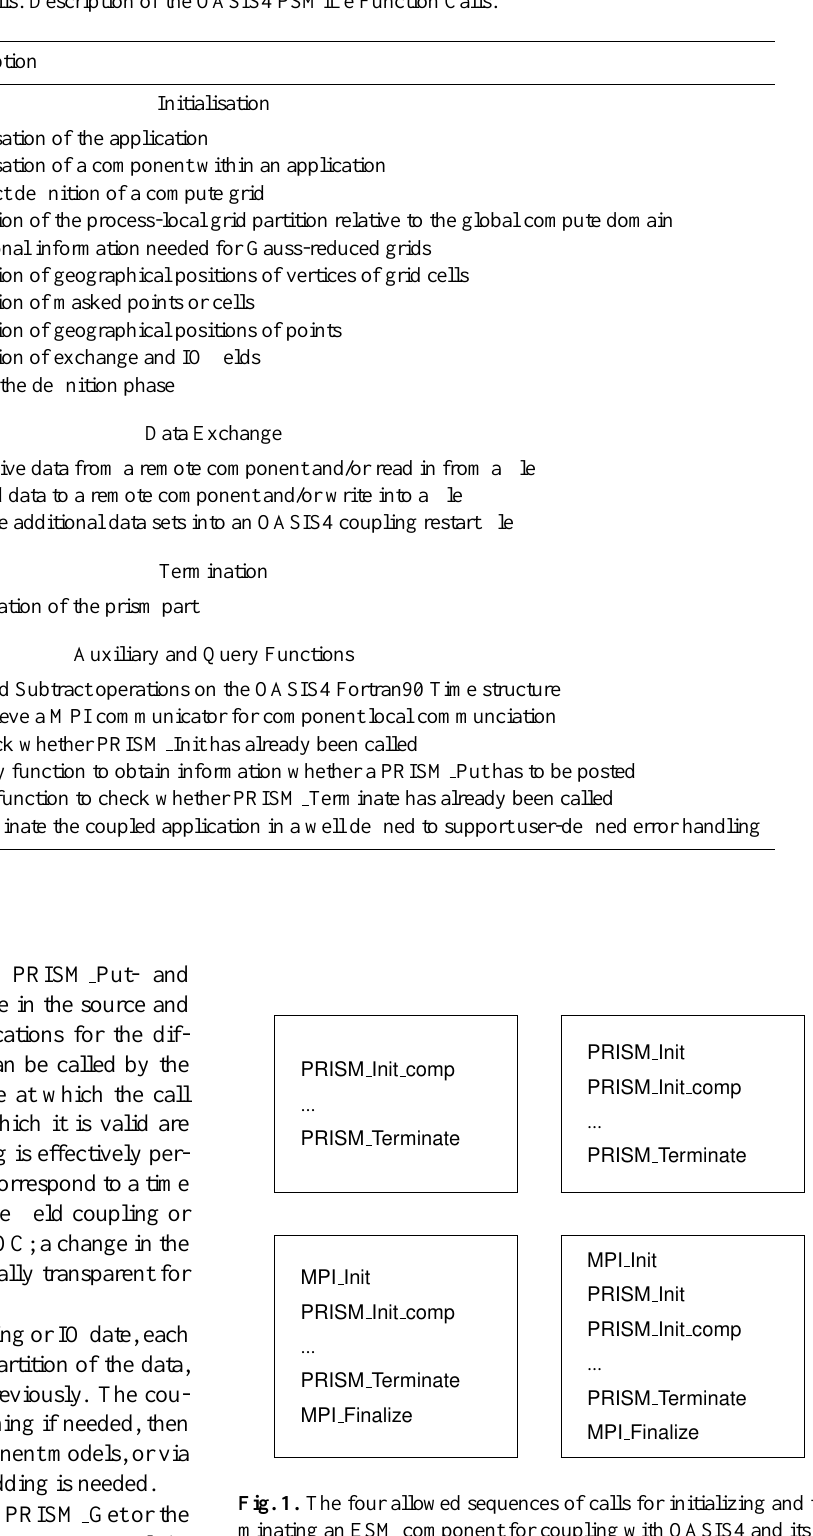
Table 1. List of OASIS4 PSMILe function calls. Description of the OASIS4 PSMILe Function Calls.